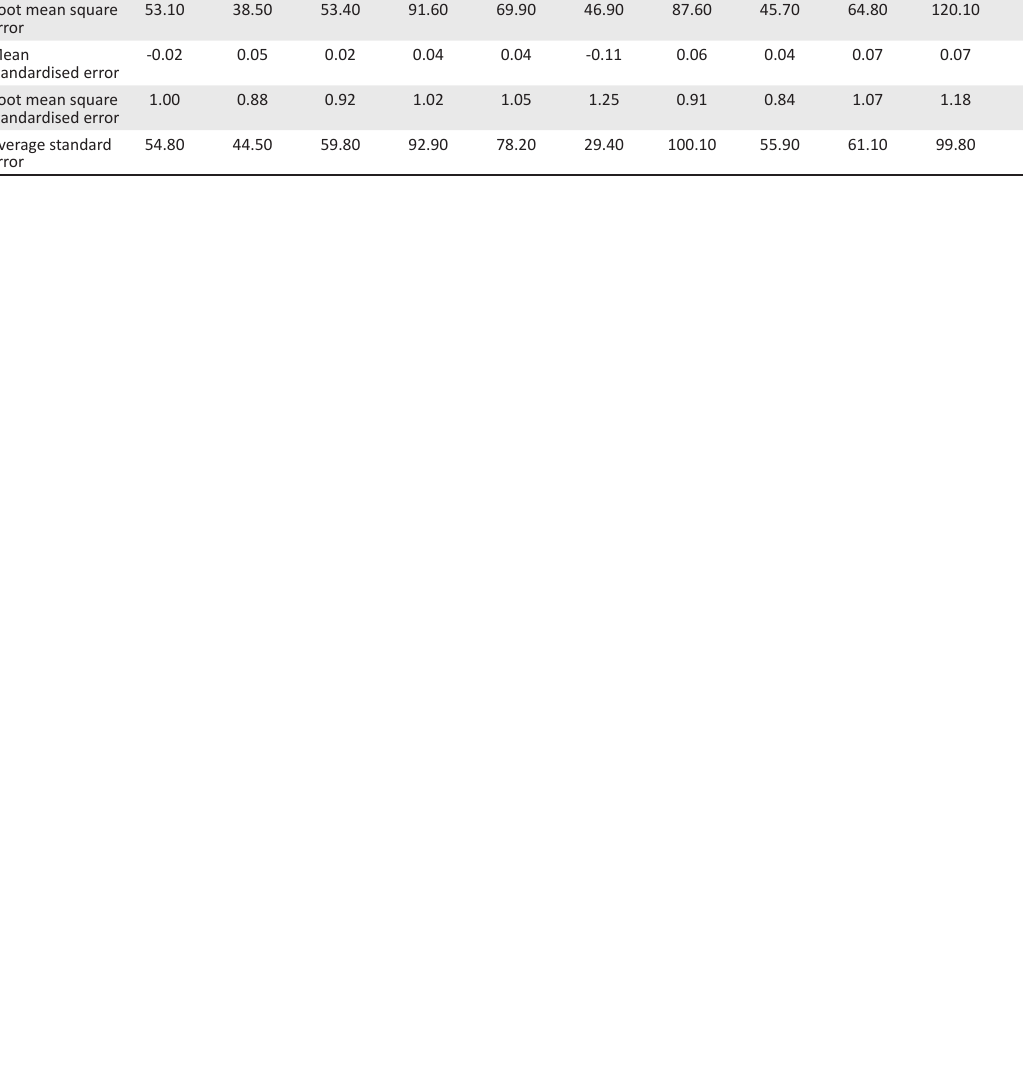
TABLE 1-A2: Summary of the cross validation results from the ordinary kriging performed to interpolate rainfall in the Tswalu Kalahari Reserve. Variable Number of rainfall stations used for interpolation